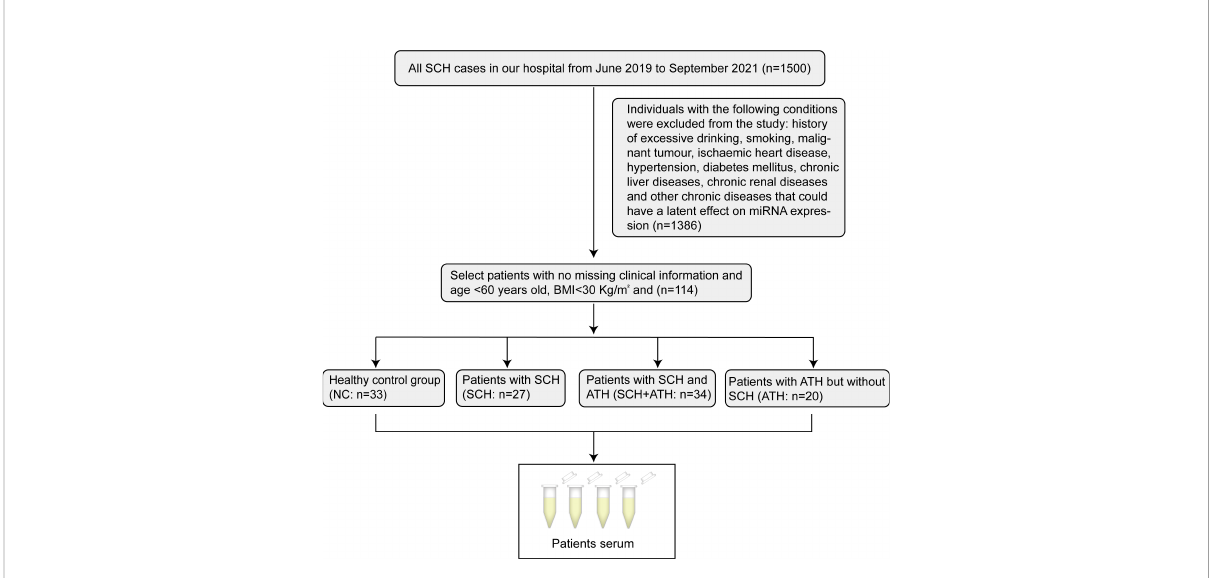
FIGURE 1 Flow chart in the study